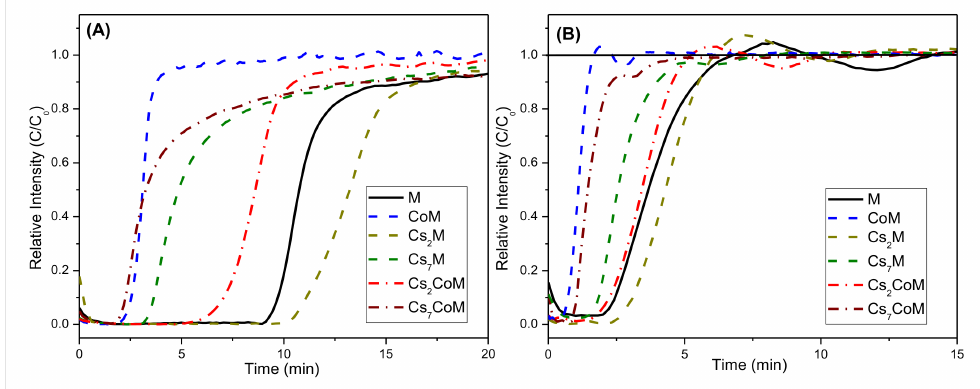
Figure 6. Breakthrough curves corresponding to the adsorption of toluene and butane mixture for M, CoM, Cs x M and Cs x CoM monoliths: ( A ) toluene; ( B ) butane. Conditions: T = 100 ◦ C, 200 mg, total flow rate = 40